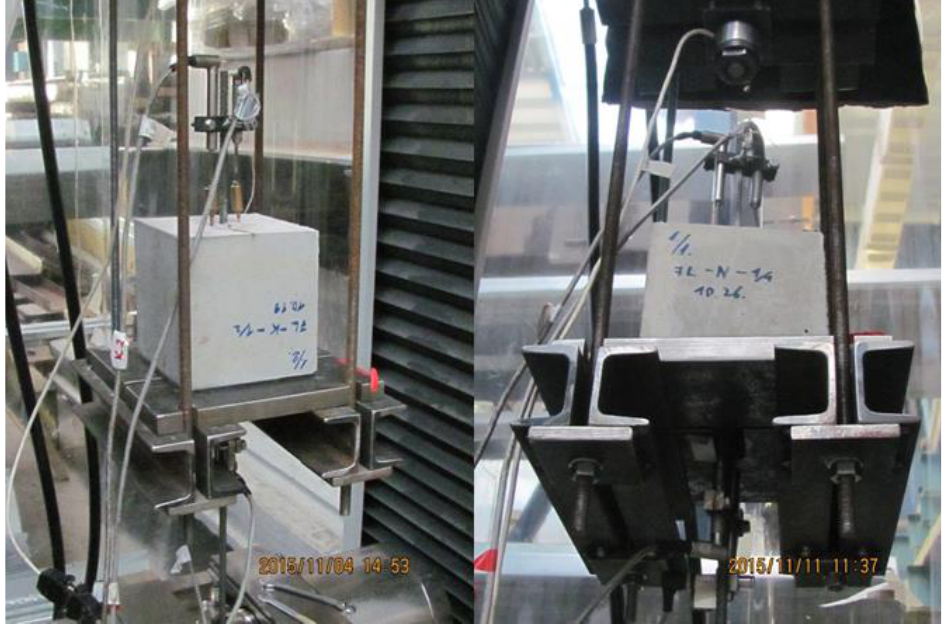
Figure 5. Pull-out test at the laboratory of BME Department of Structural Engineering.